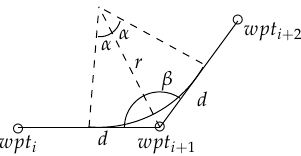
Figure 3. Geometry of a turn between waypoints. No wind